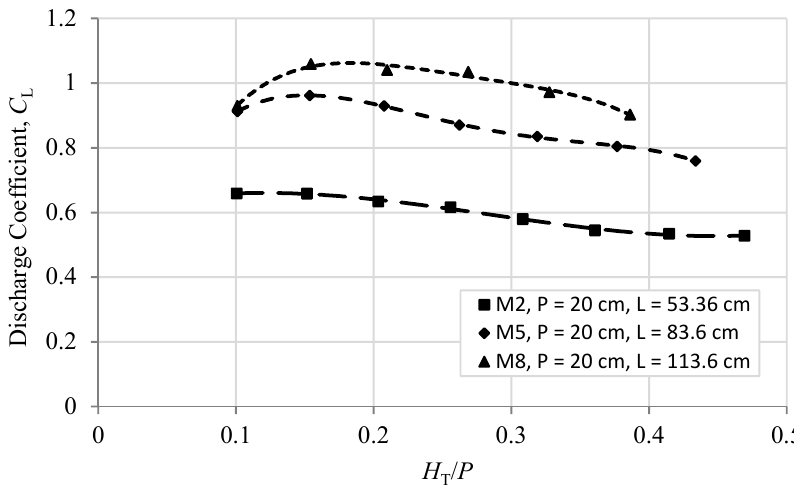
Figure 21. Discharge coefficient, C L , vs. H T /P for models M2, M5, and M8.